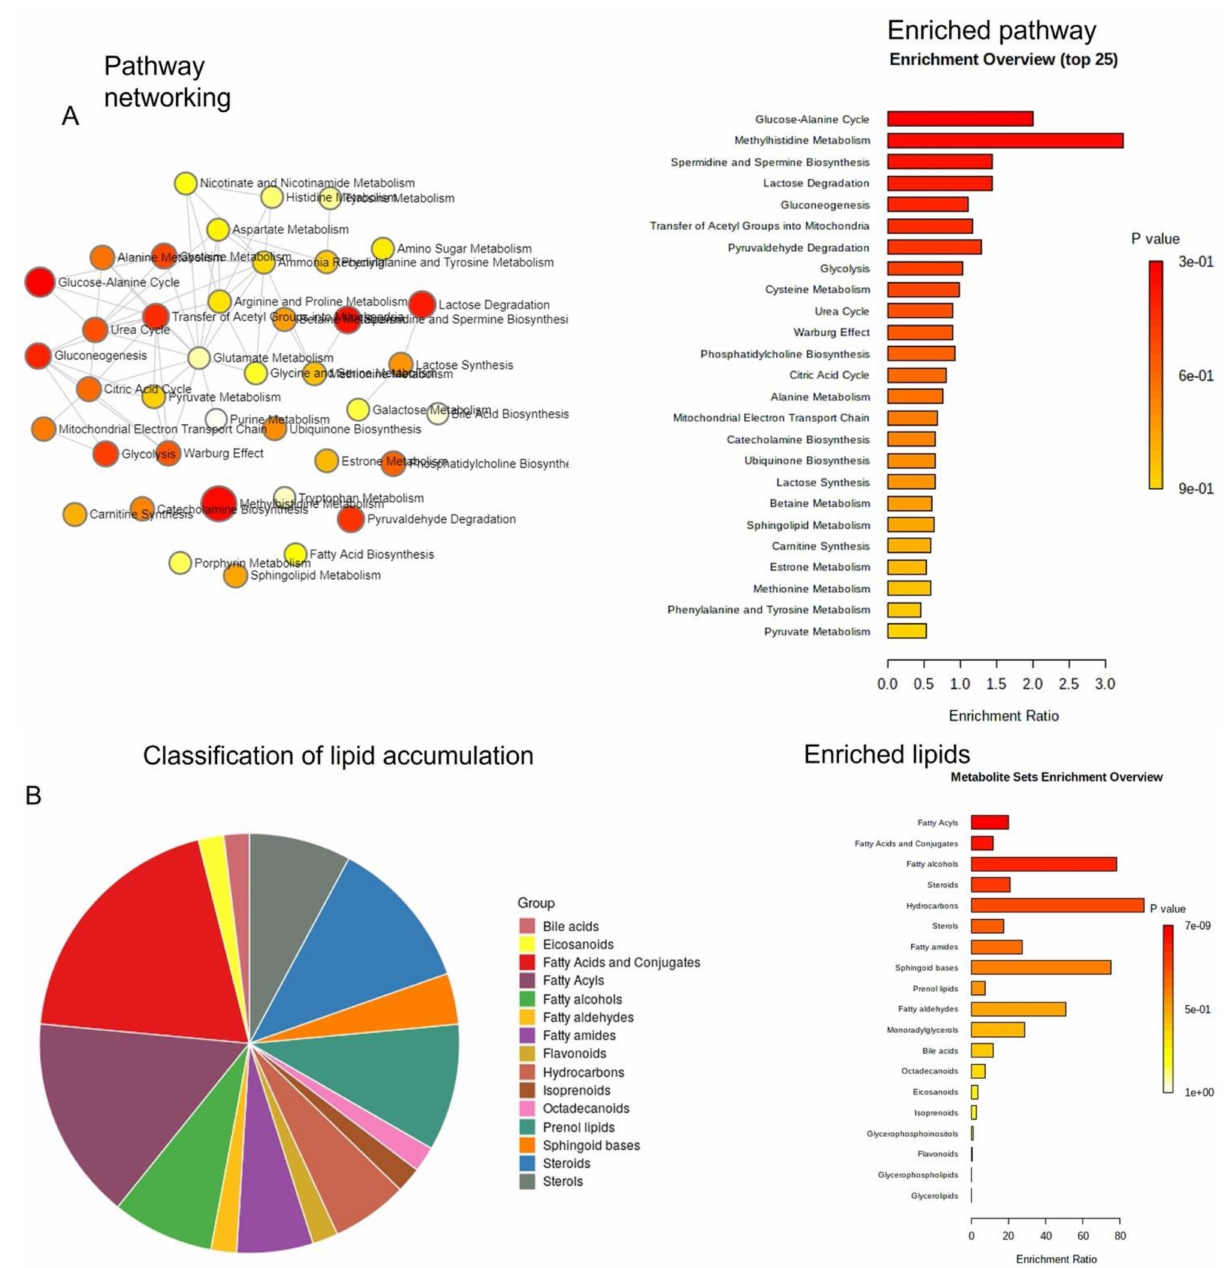
Figure 4. ( A , B ) Metabolite enrichment analysis: pathway networking, enriched pathways, and classification of accumulated lipid classes found in healthy control and COVID-19 patient